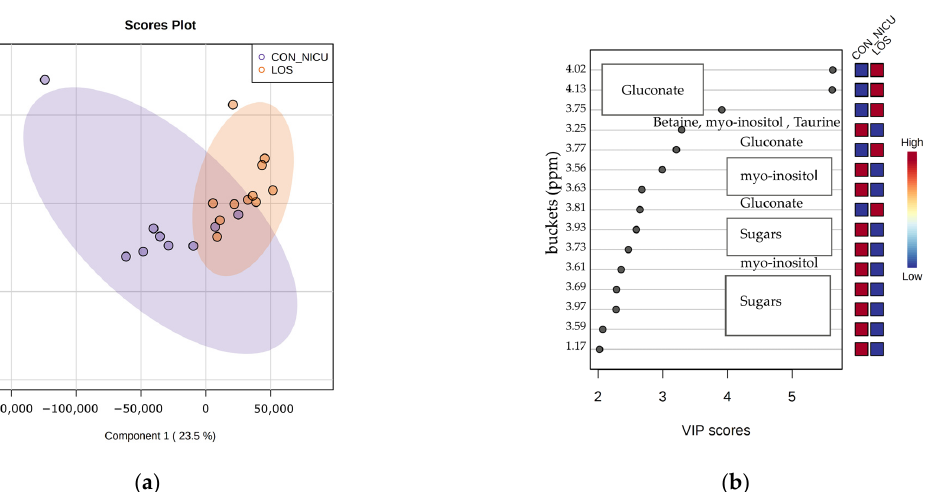
Figure 5. Multivariate analysis of NMR data belonging to neonates diagnosed with LOS (pink circles) and control neonates without need for hospitalization (blue circles). ( a ) PLS-DA scores plot of the LOS and healthy non-NICU preterms without need for hospitalization. ( b ) VIP scores and metabolites related to buckets with different concentration among the two groups. ( c ) Box plots of normalized concentration for the discriminant metabolites.